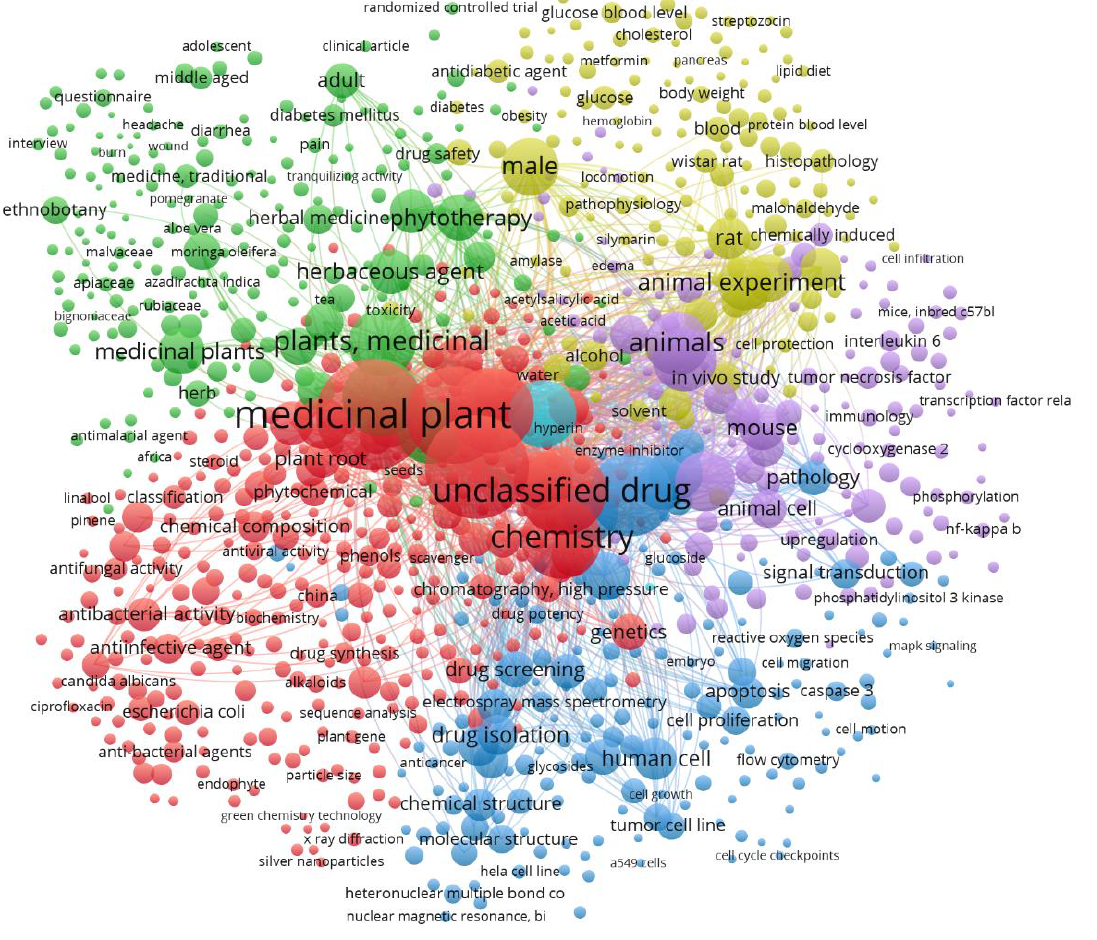
Figure 10. Network of keywords in medical plants publications: Clusters between Figure 10 . Network of keywords in medical plants publications: Clusters between 2015 – 2019 . Table 7. Main keywords used by the communities detected in the topic in the period 2015 – 2019.